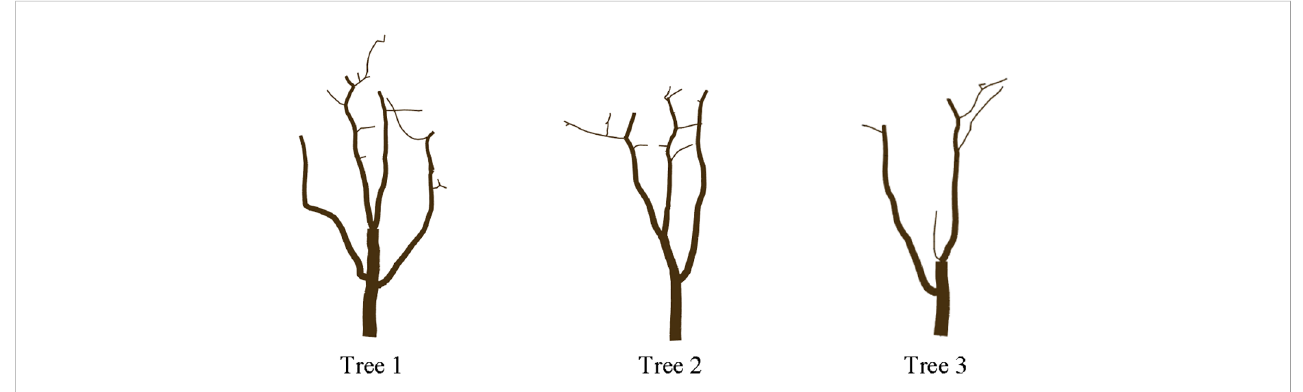
FIGURE 11 Model of jujube tree after pruning.